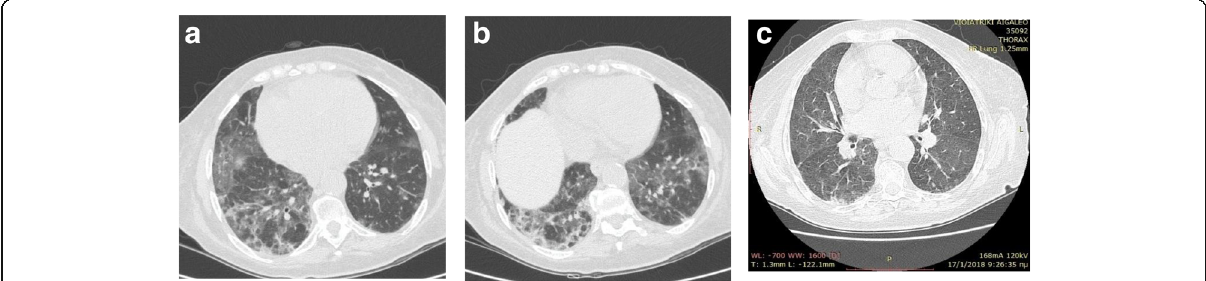
Fig. 1 Computed tomography images of a 76-year-old female with lipoid pneumonia revealed ground-glass opacities and bronchiectasis in both lungs ( a ), ( b ). The shadows improved 2 years later ( c